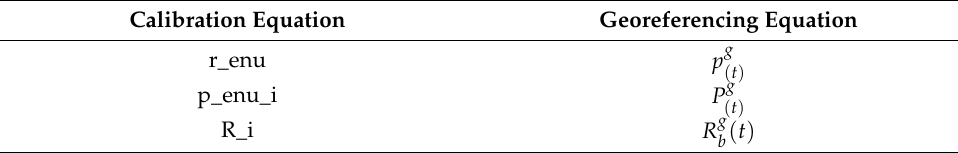
Table 5. Parameter equivalence for Algorithm